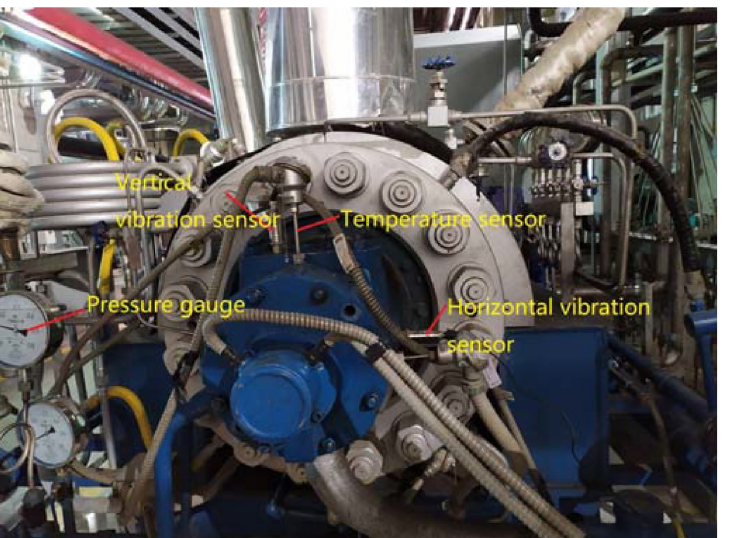
Fig 6. Diagram of local sensor